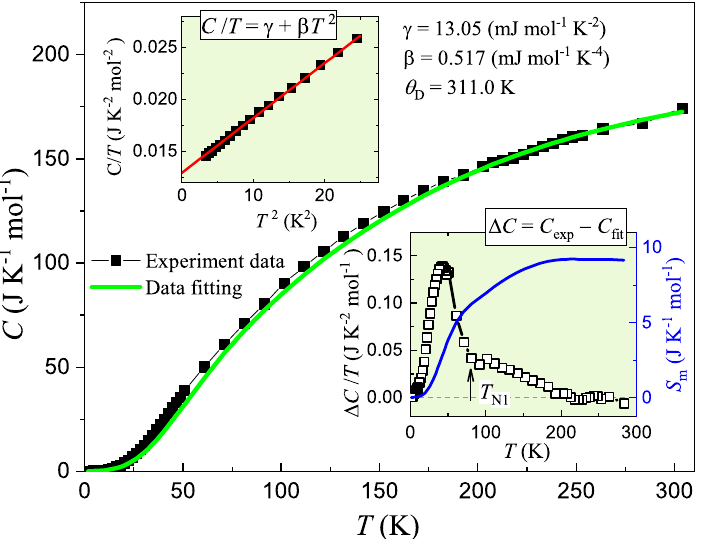
Figure 6. Temperature dependence of specific heat for Sr 2 Cr 2 AsO 3 . The upper inset shows the low-temperature specific-heat data, plotted with C / T vs. T 2 . The lower inset plots ∆ C / T (left axis) and the magnetic entropy (right axis) as functions of temperature (see text for the